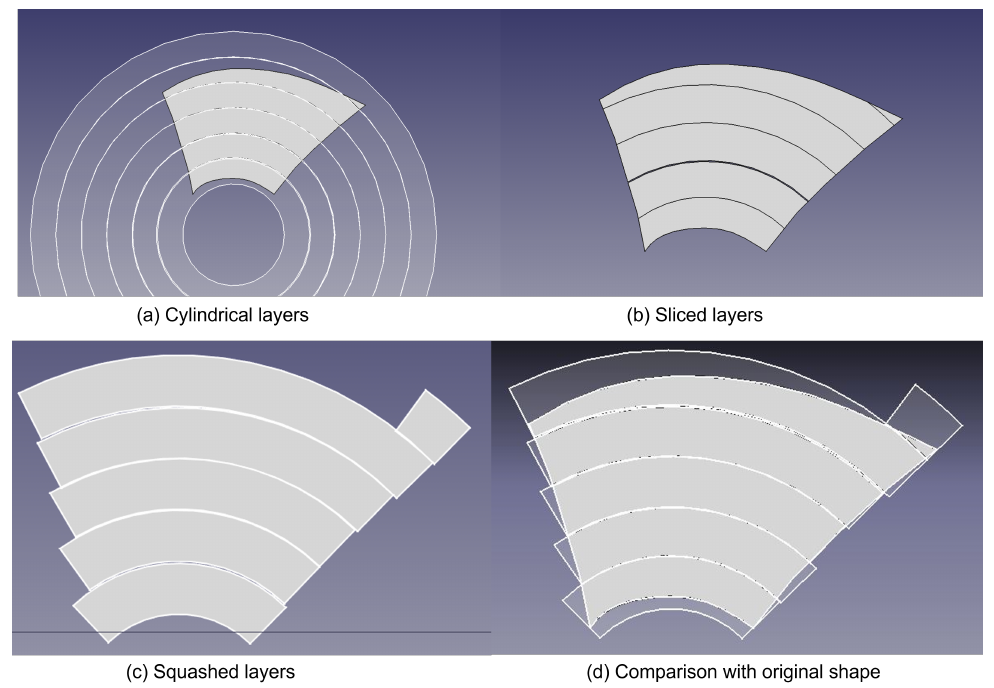
Figure 16. A result of squashing operation with cylindrical direction: ( a ) the product shape and slice layers of cylindrical direction ( b ) the product shape split by slice boundaries, ( c ) slice layers made by the proposed squashing algorithm, and ( d ) the comparison of the product shape and slice